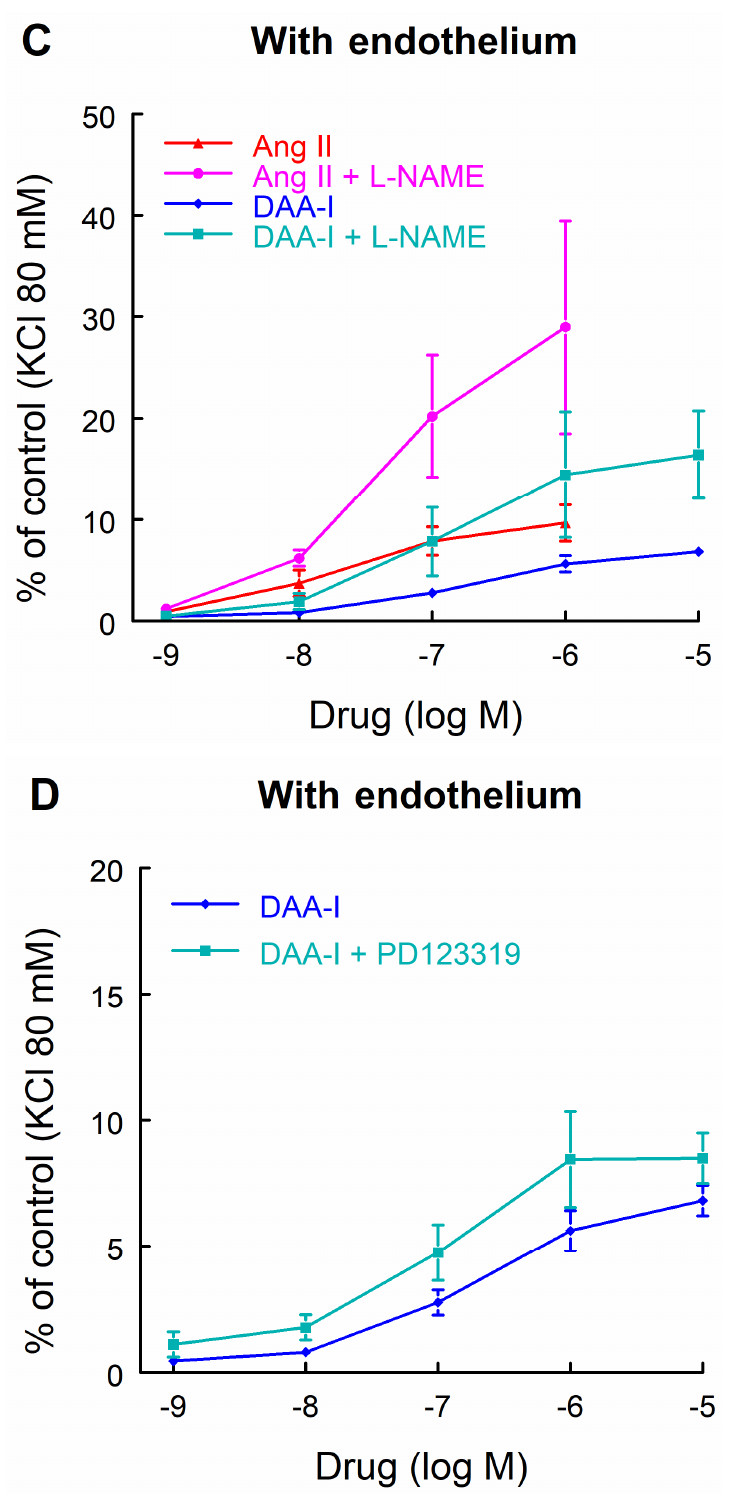
Figure 4. Concentration-response curves to DAA-I and to Ang II in aortic rings with ( A , C , D ) or without ( B ) endothelium in the presence of losartan ( A , B ), L-NAME ( C ), or PD123319 ( D ). Data were compared using a factorial ANOVA for repeated measures, taking each rat as the subject, and group and dose as the between-subjects factors. Interactions between factors were analyzed using Bonferroni method. * p < 0.01 versus the same dose of Ang II. + p < 0.001 along the curve versus its respective dose-response curve without losartan. Data are means ± SEM. n = 6 each group. KCl = potassium